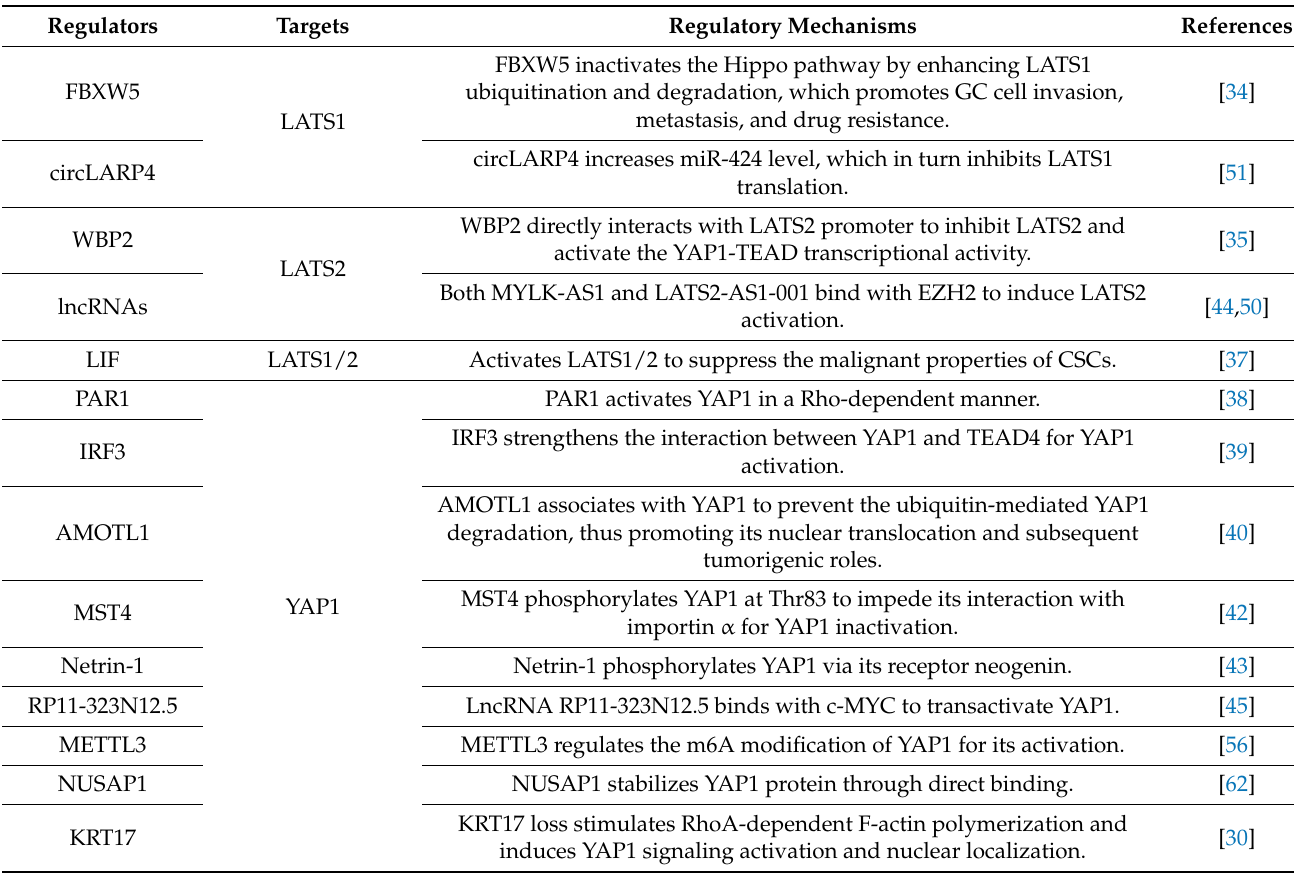
Table 1. Summary of upstream regulators and downstream targets of the Hippo pathway in